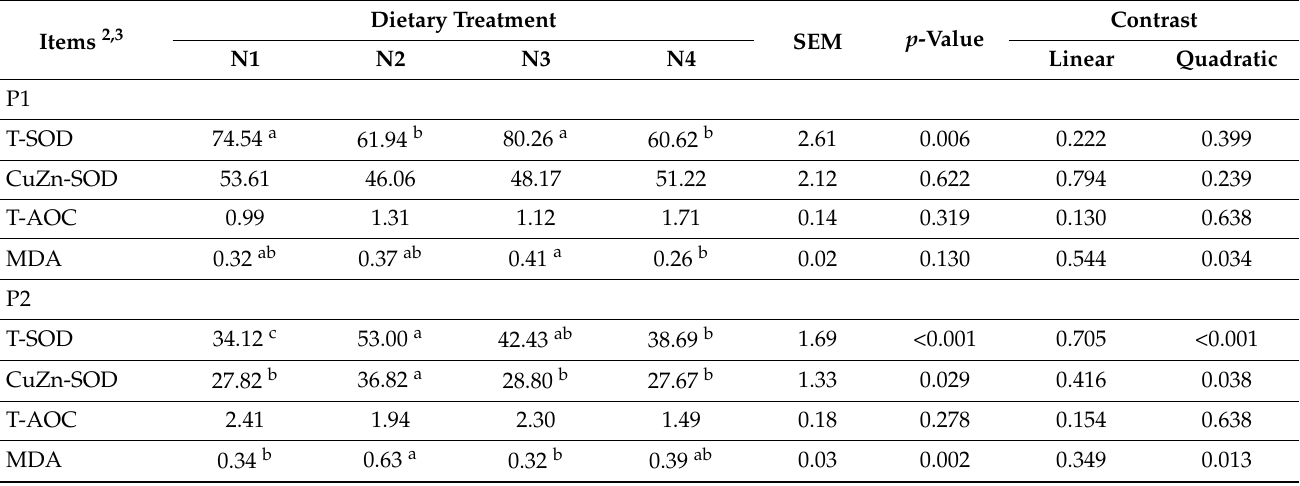
Table 4. The oxidative stress index in jejunal mucosa of weaned piglets with different niacin concentrations 1 .